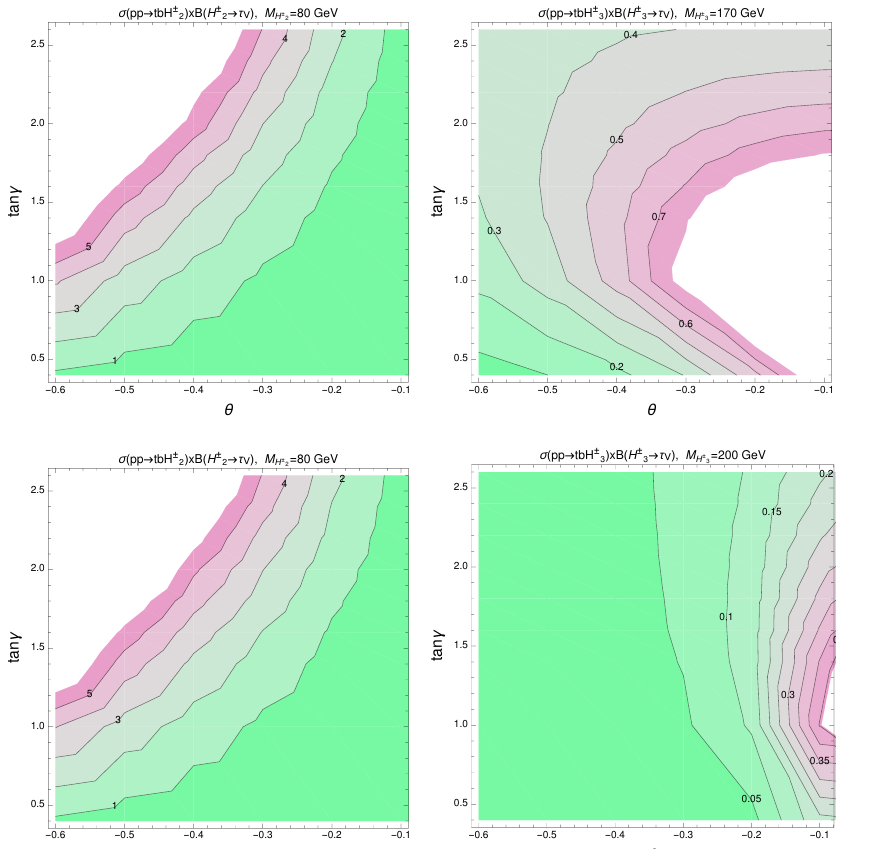
Figure 3 . Contour plots of σ ( pp → tbH ± panels) on the ( θ, tan γ ) plane, for tan β = 20 , δ = 0 . 9 π , M (upper) and 200 GeV (lower). In the case of H ± (higher) values of θ . The area in white is excluded by CMS [25]. The lower the mass of H ± the more challenging it is to find viable parameter space satisfying the direct experimental search bounds for both charged